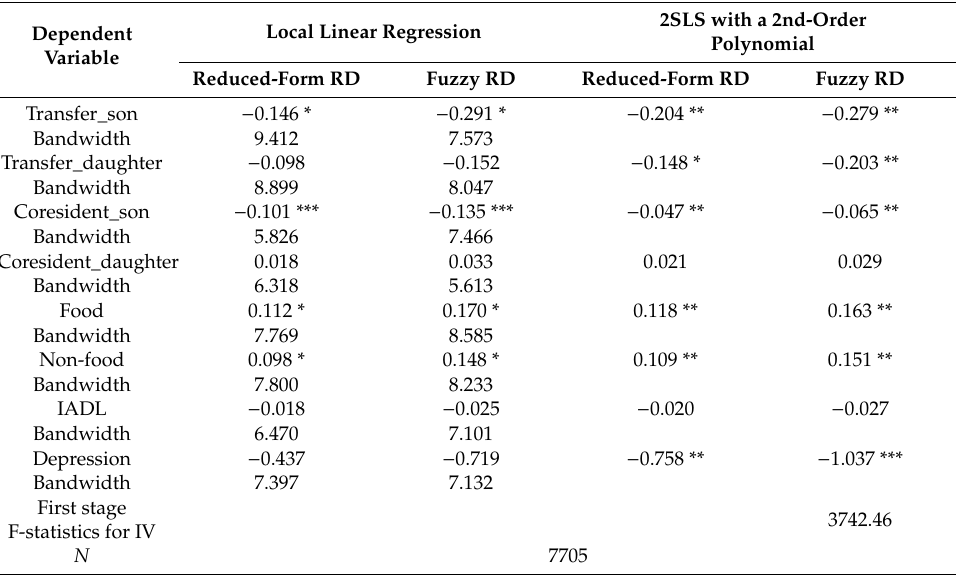
Table 3. Regression discontinuity (RD) estimation on outcomes of Interest.